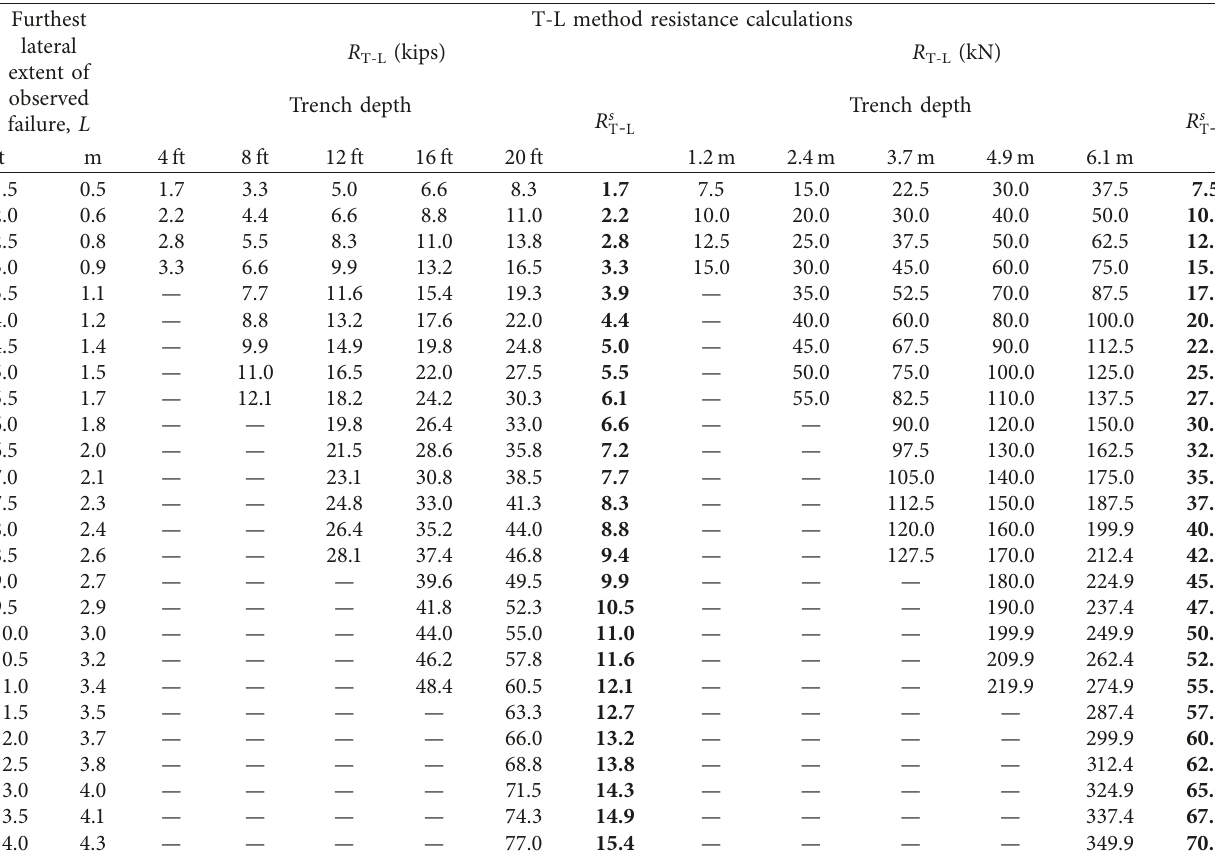
Table 1: T-L method resistance calculations as a function of the lateral extent of the observed failure. Furthest lateral extent of observed failure,